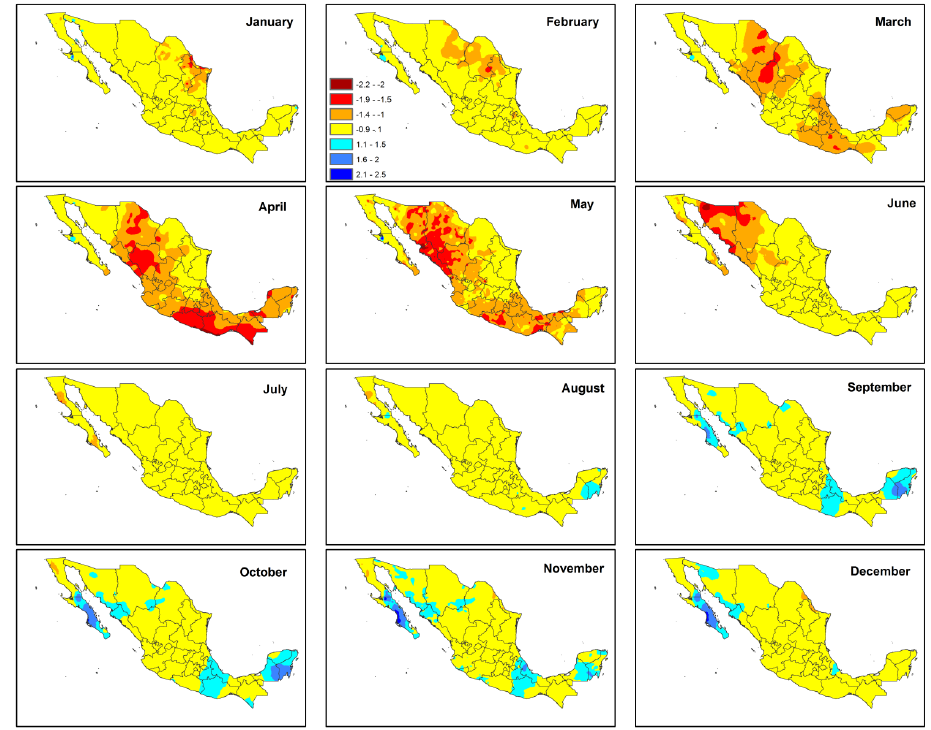
Figure 13. Drought monitoring based on TRMM 3B42 six-month Standardized Precipitation Index for 2012.